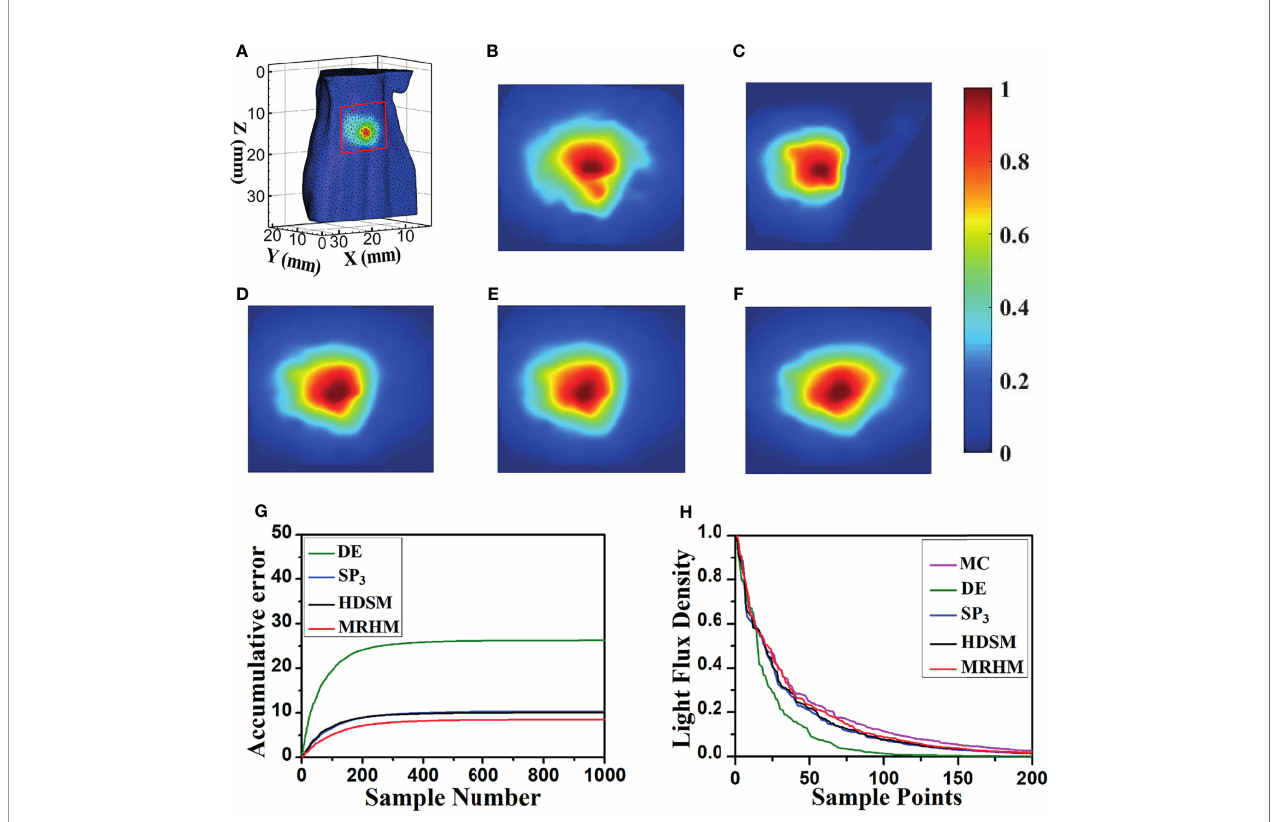
FIGURE 5 | Results of forward simulation at 610 nm. (A) The surface luminescence fl ux illustration of the digital mouse model. (B – F) The surface luminescence fl uxes projected onto the X – Z plane simulated by the MC, DE, SP 3 , HDSM, and MRHM, respectively. (G) Accumulative error for each model. (H) The descending order of surface light fl ux of each